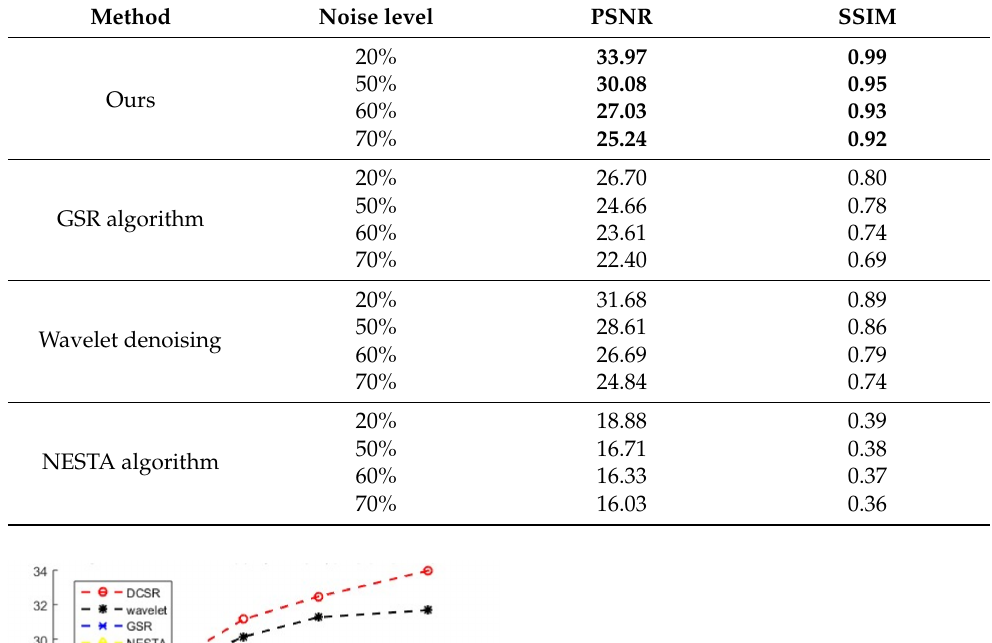
Table 1. Quality metric results on different algorithms for different values of noise levels.